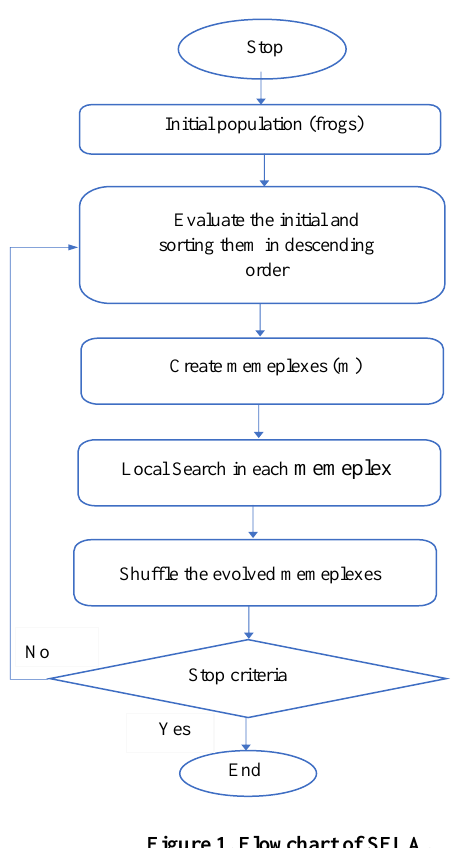
Figure 1. Flowchart of SFLA.